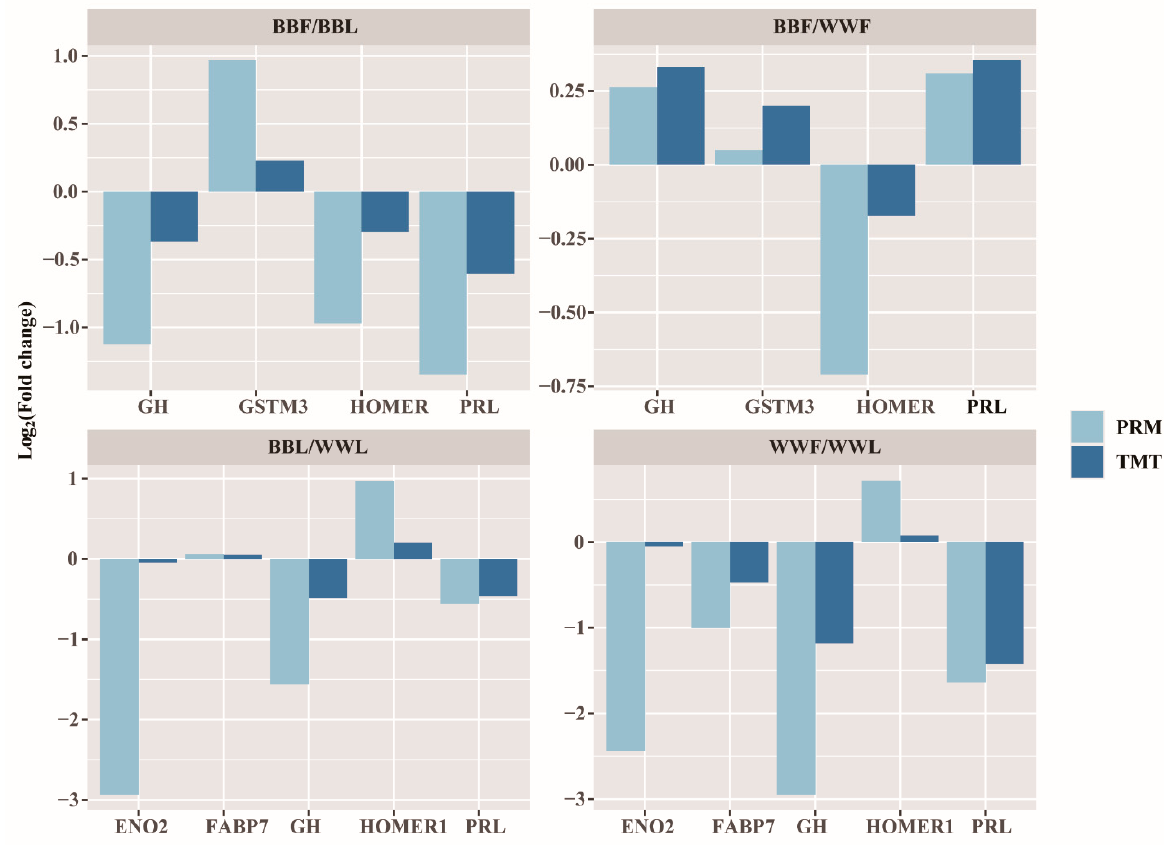
Figure 2. Comparison of protein abundance profiles obtained by PRM and TMT protein quantification techniques. Growth hormone (GH), glutathione S-transferase mu 3 (GSTM3), homer scaffold protein 1 (HOMER1) and prolactin (PRL) proteins were selected for protein abundance validation in the follicular phase versus the luteal phase of BB ewes (BBF/BBL groups) and in BB ewes compared with WW ewes at the follicular phase (BBF/WWF groups). PRL, GH, HOMER1, fatty acid binding protein 7 (FABP7) and enolase 2 (ENO2) proteins were selected for protein abundance validation in the follicular phase versus the luteal phase of WW ewes (WWF/WWL groups) and in BB sheep compared with WW sheep at the luteal phase (BBL/WWL groups). The log 2 fold change values were calculated between the different groups. The protein abundance measured by the PRM method compared with the TMT method for the selected genes in all four groups showed the same trend.